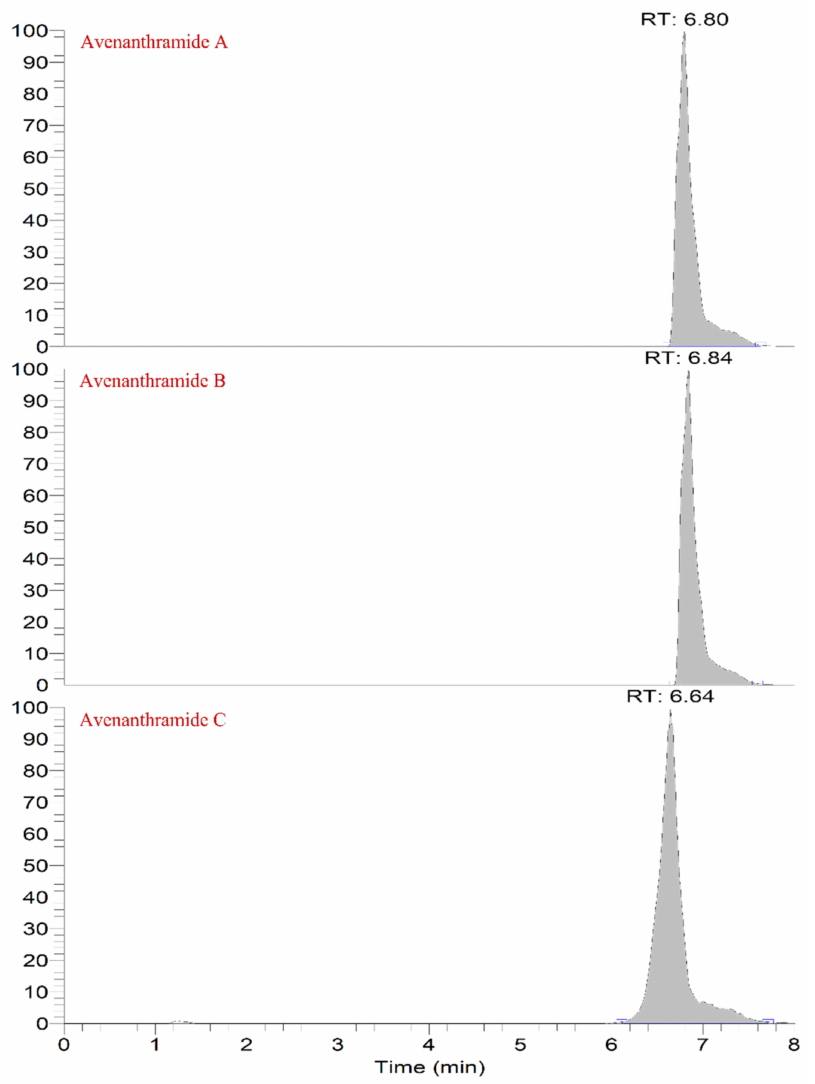
Figure 2. Chromatograms of the three